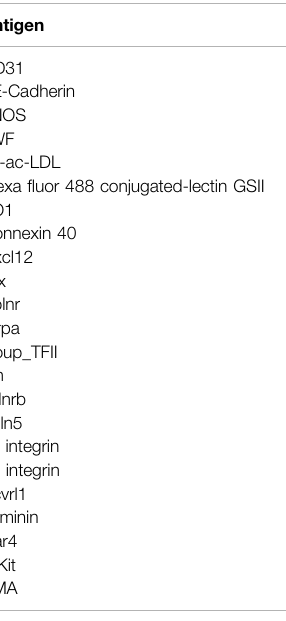
TABLE 1 | Antibodies used for immunostaining and western